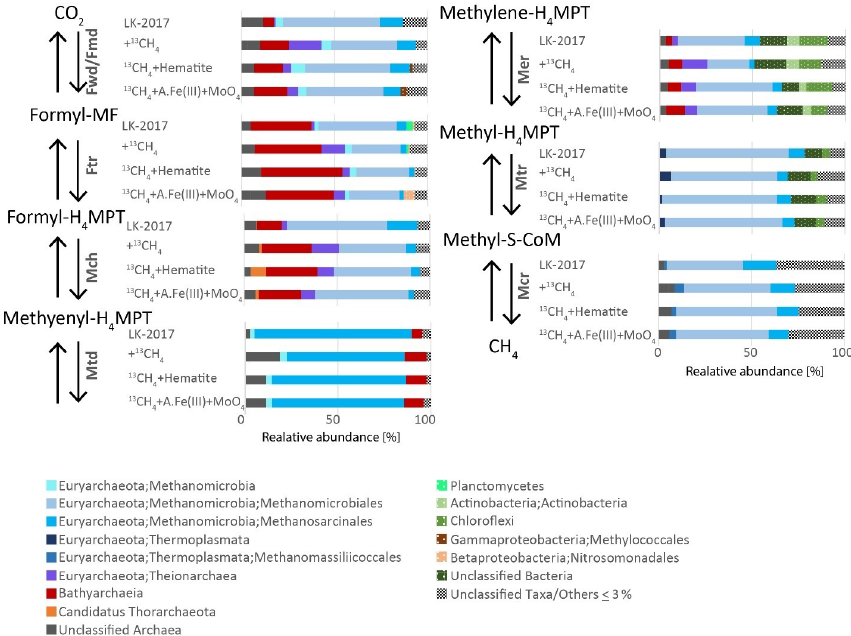
Figure 3. Phylogenetic diversity of the seven core genes of methanogenesis from CO 2 . Phylogenetic assignments are based on BLAST map- ping against the RefSeq database. Taxonomic classifications at the highest level possible (up to the order level) are shown. A.Fe(III) + MoO 4 : amorphous iron and